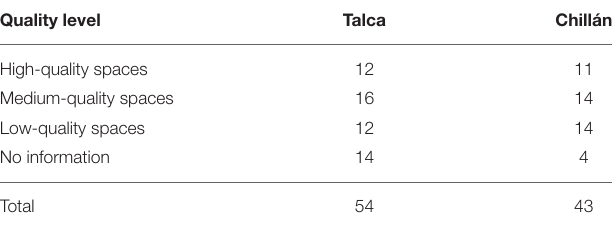
FIGURE 2 | Location of the two Chilean cities in this study: Talca and Chillán. Source: own elaboration. TABLE 1 | Number of parks and neighborhood squares (green areas) in Talca and Chillán according to the three different quality levels as elaborated by INE